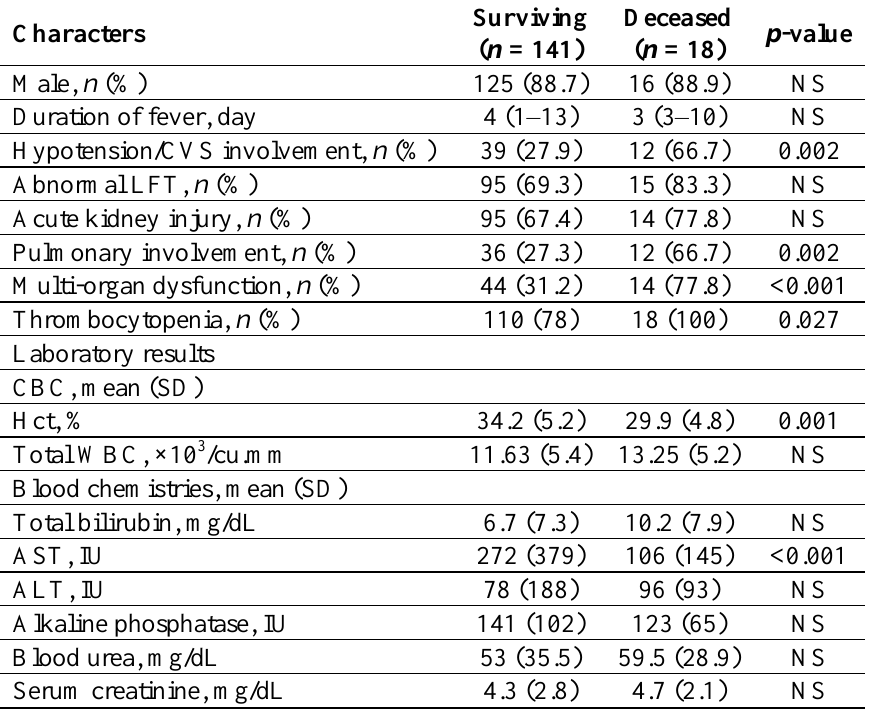
Table 3. Clinical characteristics and laboratory results compared between patients who survived and those who